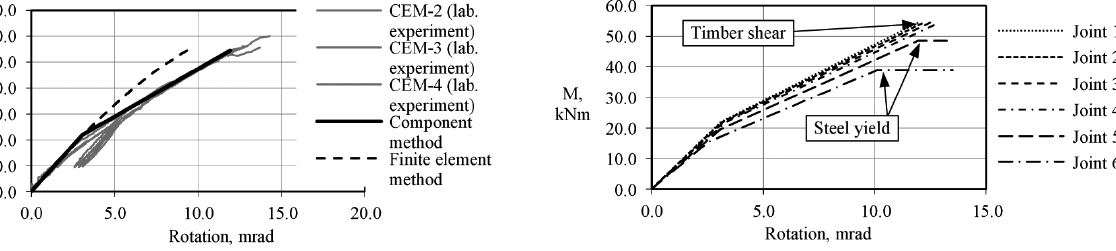
thicknessesFig. 9. Comparison between different moment-rotation curves: component method based theoretical, experimental and finite element